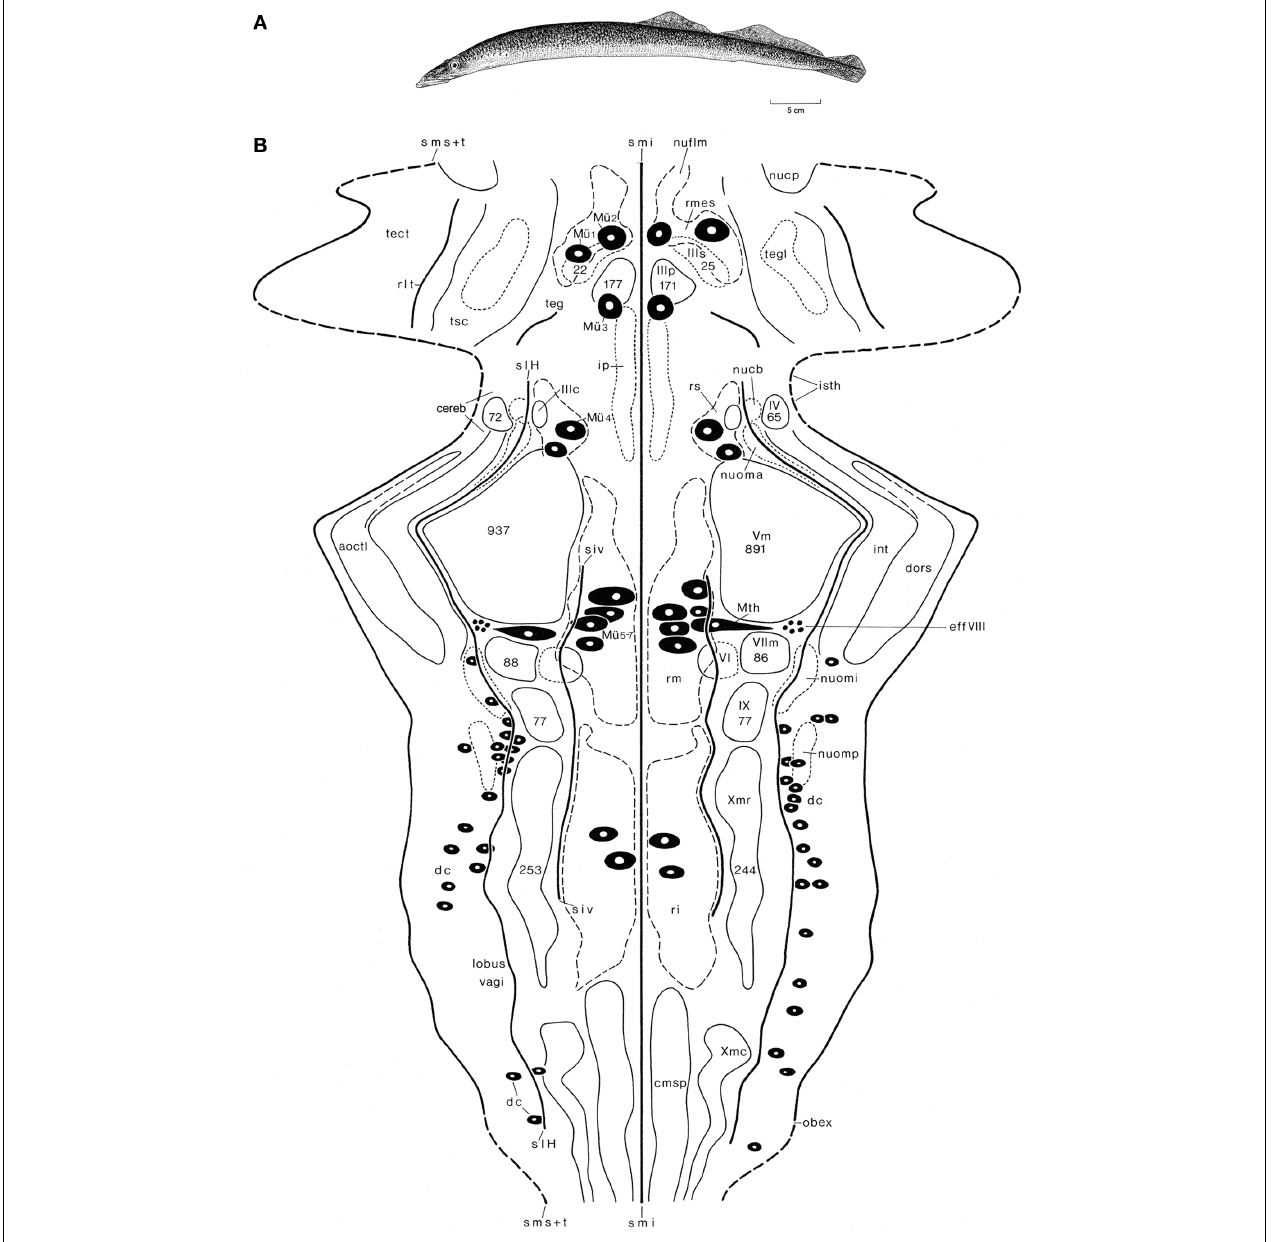
FIGURE 4 |The lamprey Lampetra fluviatilis . Holotype (A) , and topological chart of the brainstem (B) .The numbers of cells, present in some nuclei are, indicated by numerals enclosed within the outline of the structure. Modified from Nieuwenhuys and Nicholson (1998).